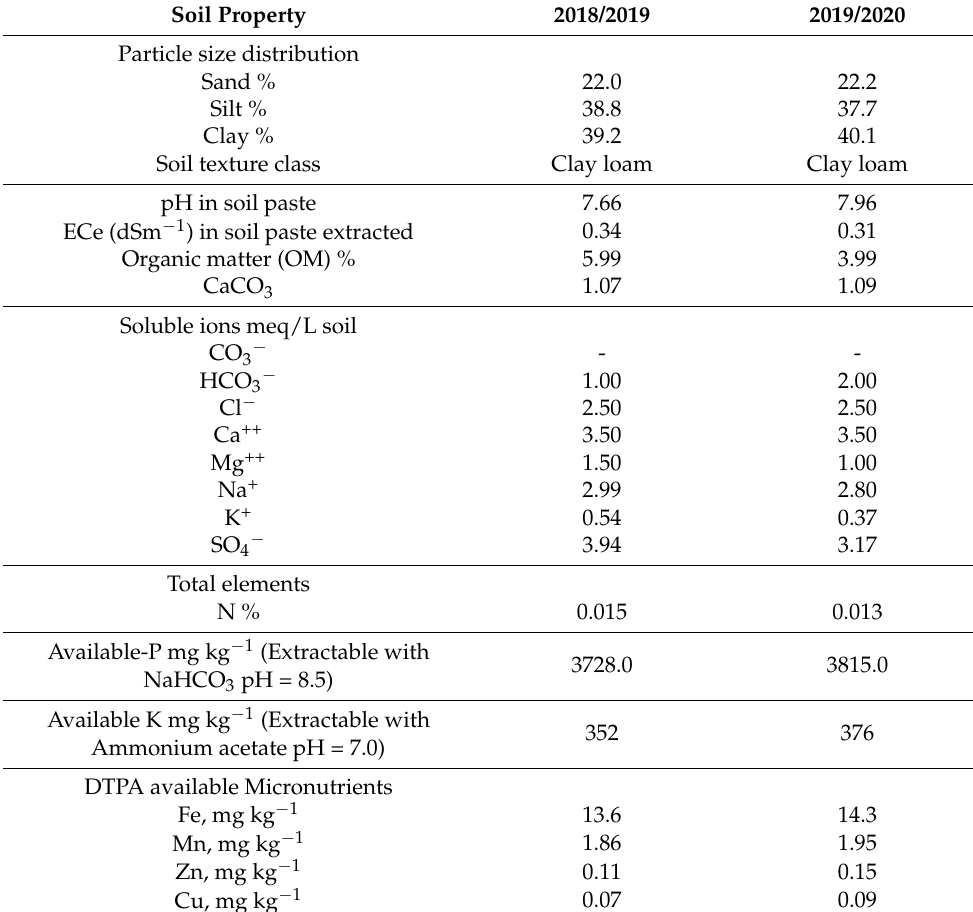
Table 4. Some soil physical and chemical properties of the experimental fields in 2018/2019